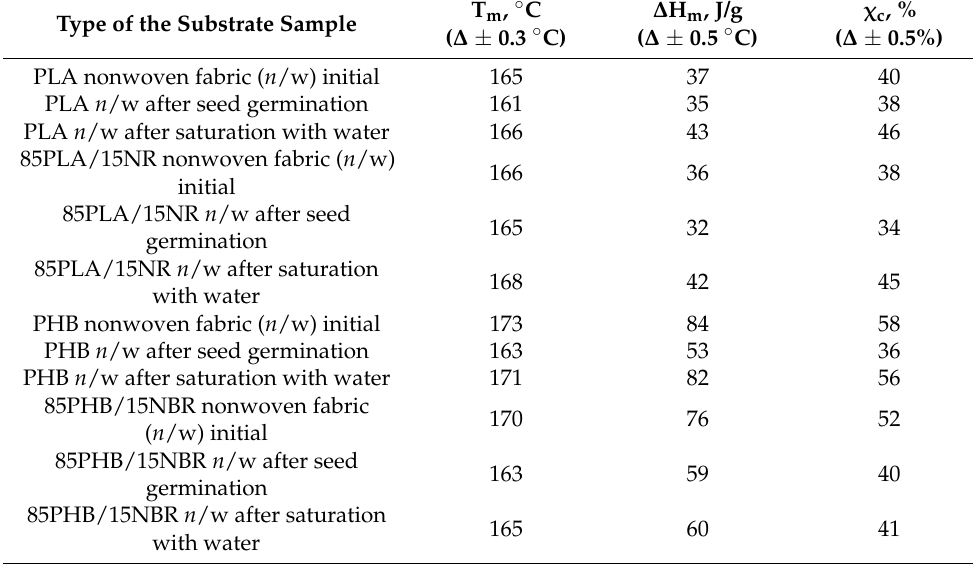
Table 2. Thermophysical characteristics of PLA, PHB, and their fiber composites. Type of the Substrate